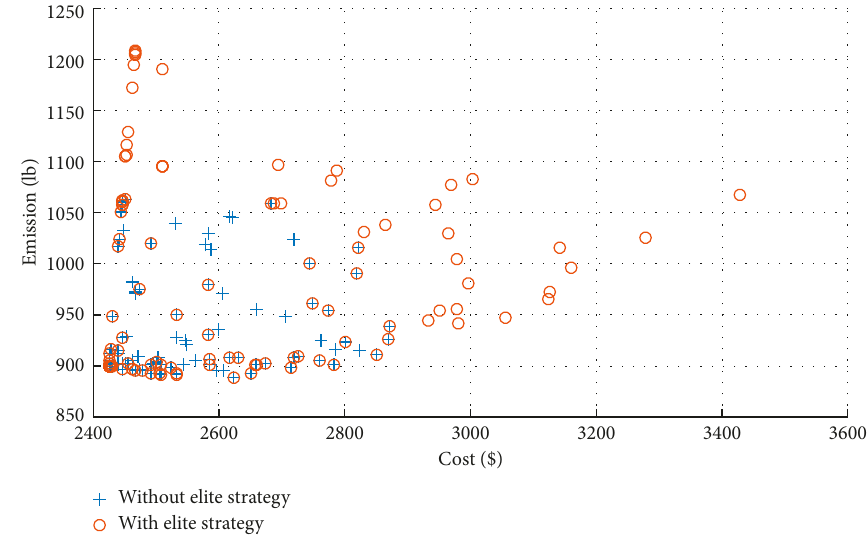
Figure 9: Impact of the elitist nondominated sorting strategy on individual screening. Table 13: Comparison with and without the proposed constraint handling